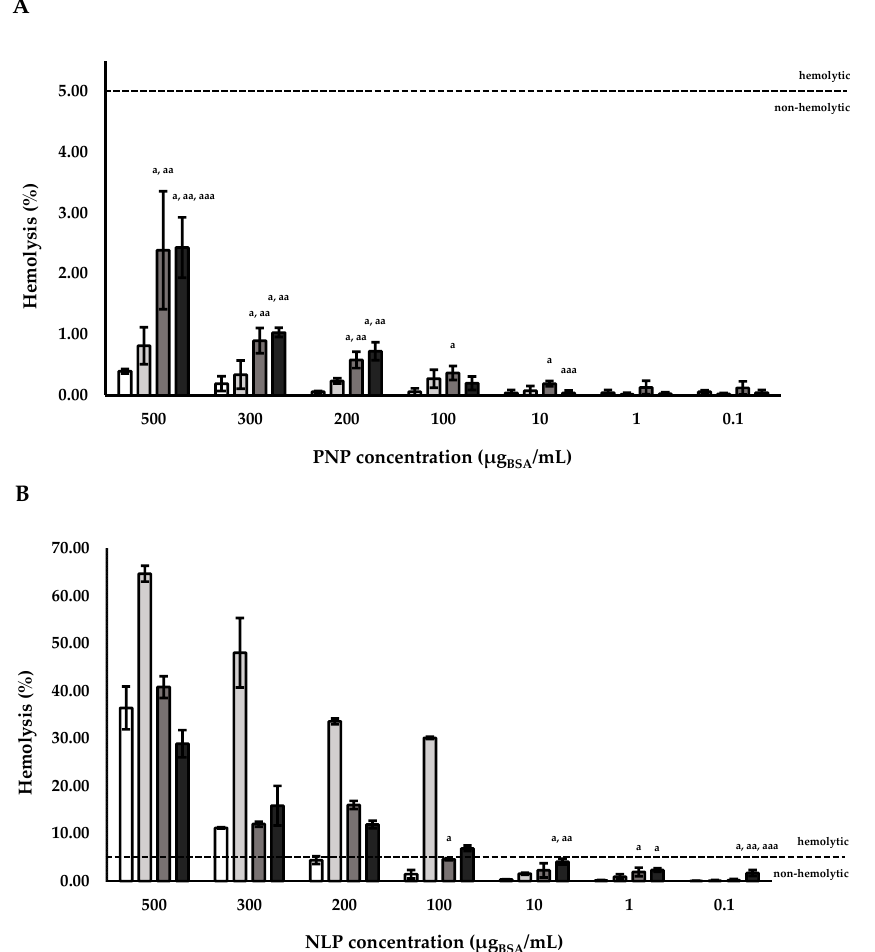
Figure 4. Hemolysis percentage of RBCs after contact with different concentrations of ( A ) PNPs : PNP E , PNP BSA (30 mg/mL) , PNP BSA (35 mg/mL) , PNP BSA (40 mg/mL) and of ( B ) NLPs : NLP E , NLP BSA (3 mg/mL) , NLP BSA (4 mg/mL) , NLP BSA (6 mg/mL) . RBCs: red blood cells, PNP E : empty polymeric nanoparticles, PNP BSA : BSA-loaded polymeric nanoparticles, NLP E : empty nanoliposomes, NLP BSA : BSA-loaded nanoliposomes. Data are expressed as mean of three measurements. Error bars indicate SD. Different symbols refer to statistically significant differences among results ( p < 0.05, ANOVA with Tukey’s HSD post hoc multiple comparison test). a : statistically different to empty nanocarriers (PNP E or NLP E ), aa : statistically different to PNP BSA (30 mg/mL) or NLP BSA (3 mg/mL) , aaa : statistically different to PNP BSA (35 mg/mL) or NLP BSA (4 mg/mL) . The dotted line refers to 5% of hemolysis.